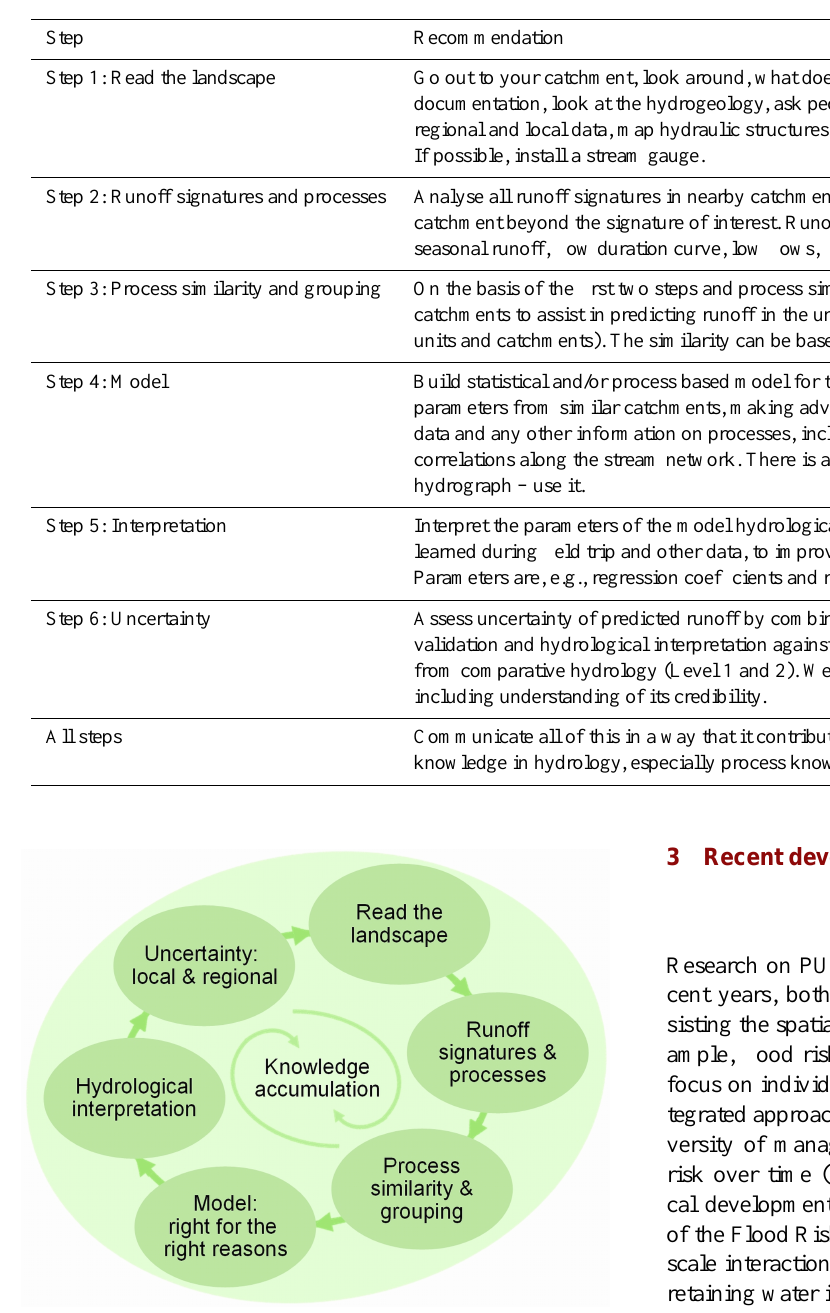
Figure 1. Best practice recommendations for predicting runoff in ungauged basins (from Takeuchi et al.,